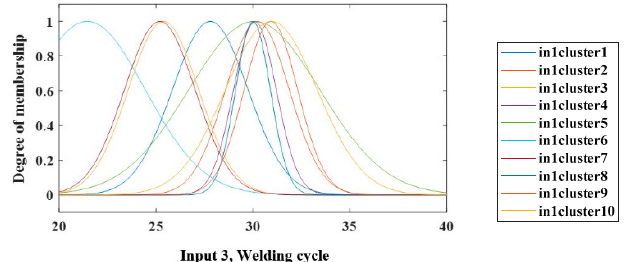
Figure 7. Optimized membership functions for the welding cycle.